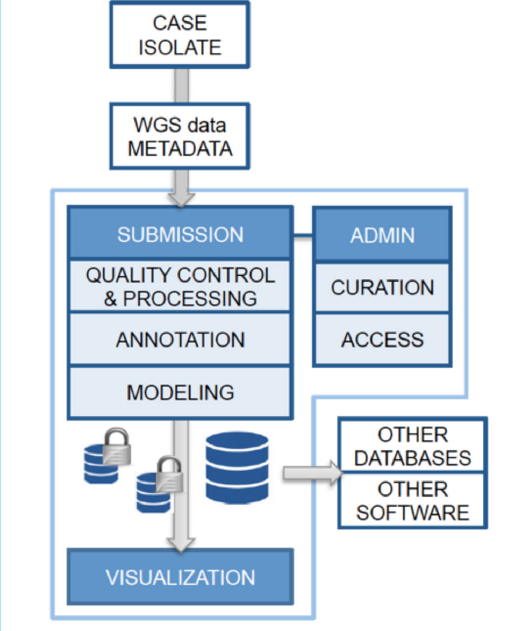
Figure 2: Envisioned workflow for the surveillance platform. After isolating a strain, collecting epidemiological data and se- quencing it, the user uploads raw data and metadata into a central or local/private database using the submission portal. After sub- mission, these data are quality controlled and then (semi-)auto- matically processed, to perform e.g. genome assembly, and MLST, SNP and resistance calling. The resulting data are used for phylo- genetics and predictive modelling of e.g. transmission dynamics. All these data are stored in a structured database with controlled access, and visualised in a user-friendly interface. For open-data, the structured database may also be used/queried by other appli- cations or pushed to external databases and knowledge bases. In addition to the submission portal, an administration portal will be developed, notably to manage users and rights, as well as a curat- ing portal to edit controlled vocabularies and define curated refer- ence strains and variants (e.g., for